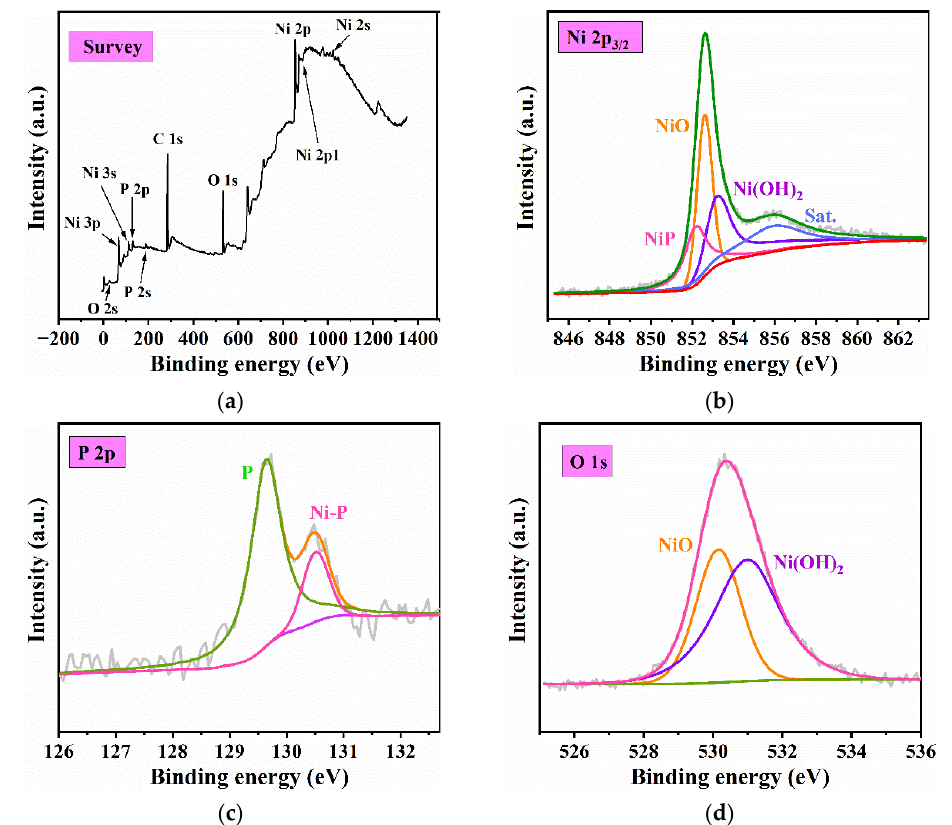
Figure 10. ( a ) XPS survey spectra; ( b ) XPS spectra of Ni 2p 3/2 core level regions; ( c ) XPS spectra of the P 2p core level regions; ( d ) XPS spectra of O 1s core level regions.